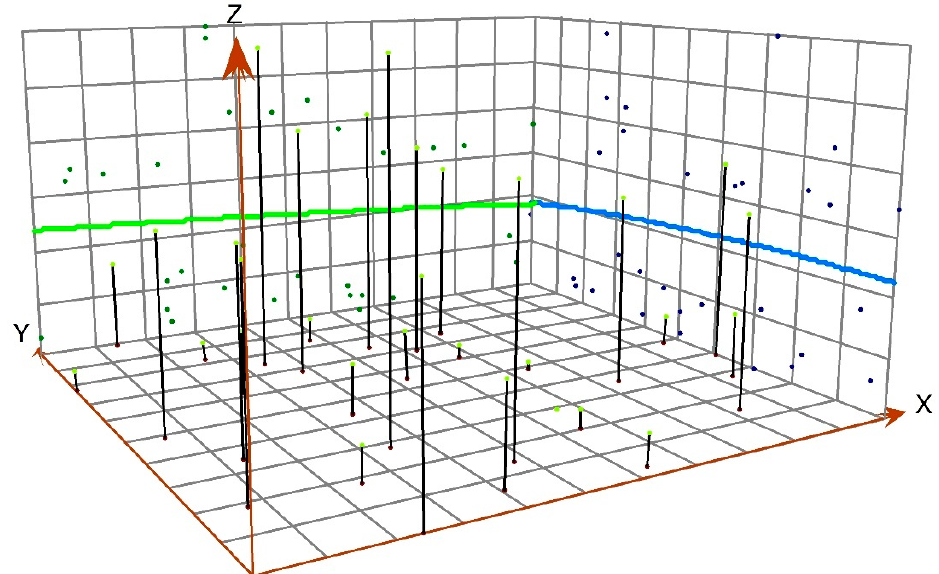
Figure 4. Trend analysis results (the arrow on the X-axis indicates an eastward direction. the arrow on the Y-axis indicates a northward direction. The Z-axis indicates the EWP value. The green line indicates the trend of EWP in the east-west direction. The blue line indicates the upward trend of EWP in the south and north).